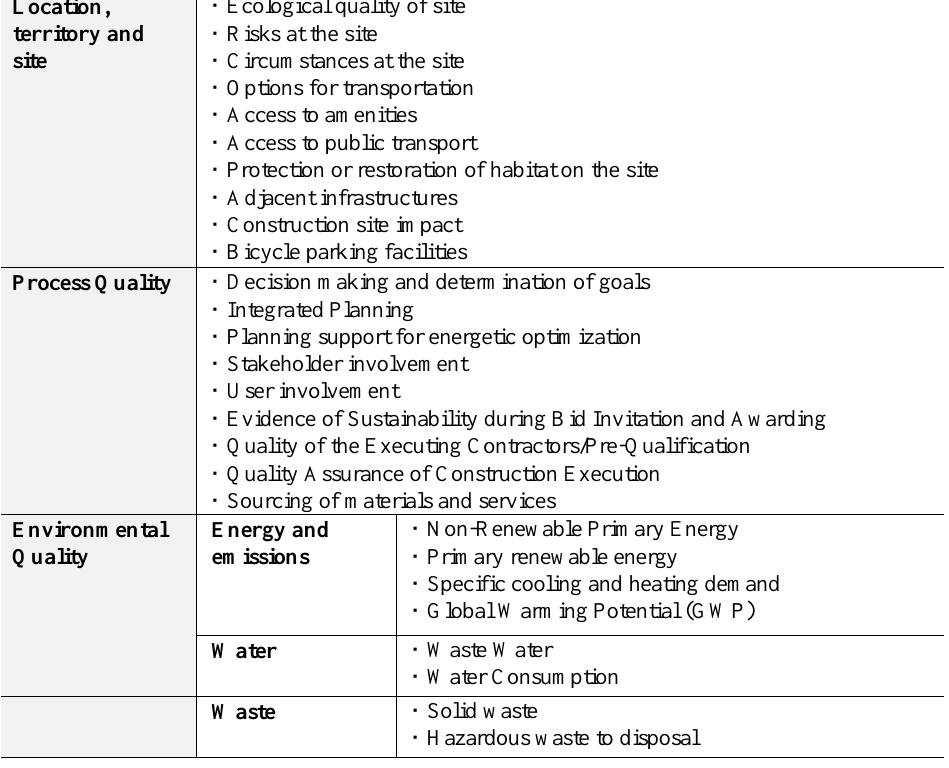
Table 1 – Reference Performance Indicators of Building Sustainability (Quality) Location, territory and